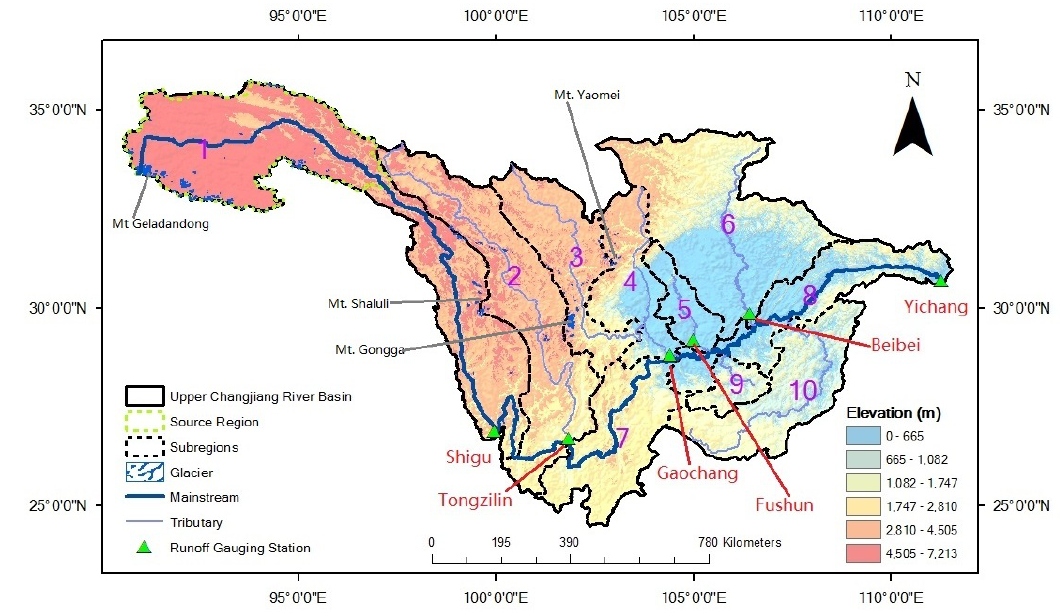
Figure 1. Map of the Upper Changjiang River Basin (see Section 2.1 for details). Blue shaded areas are the glaciers extracted from “The second Chinese glacier inventory”